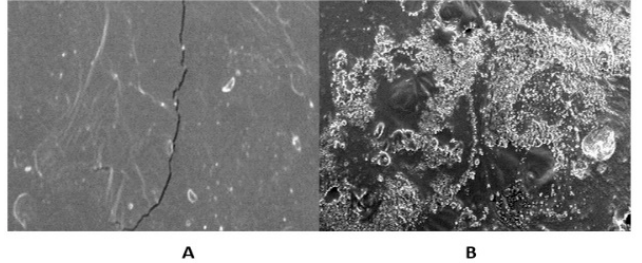
Figure 9. Film dimensions and its adhesion to the buccal mucosal membrane.